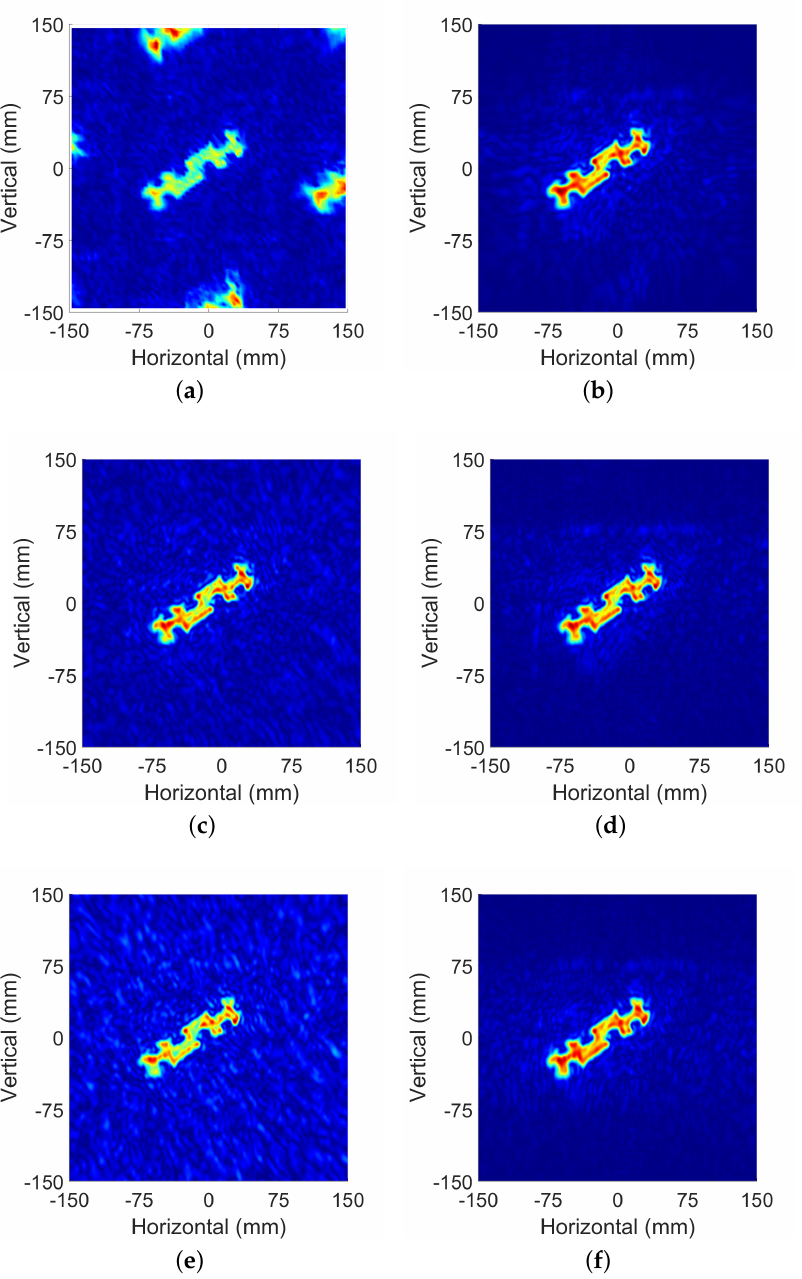
Figure 12. Reconstructed images under different sampling conditions: ( a ) image reconstructed from under-sampled data with a d x = 3.84 d y = 4 mm scan step; ( b ) image reconstructed from under- sampled data with a d x = 3.84 d y = 4 mm scan step with proposed method. ( c ) Reconstruction results of the SAR data with USR = 60% by match filter method. ( d ) Reconstruction results of the SAR data with USR = 60% by proposed method. ( e ) Reconstruction results of the SAR data with USR = 30% by match filter method. ( f ) Reconstruction results of the SAR data with USR = 30% by proposed